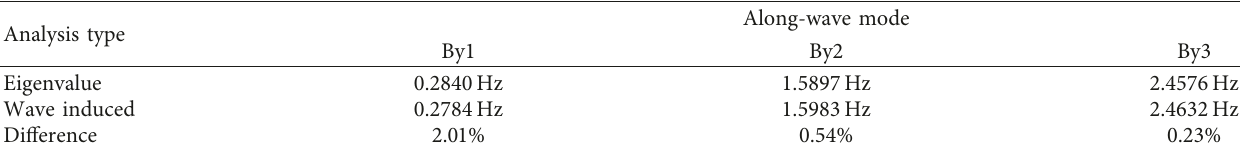
Figure 14: Modal parameter estimation for across-wave bending modes. (a) Singular value chart (b) Mode shapes. Table 8: Natural frequencies of across-wave bending